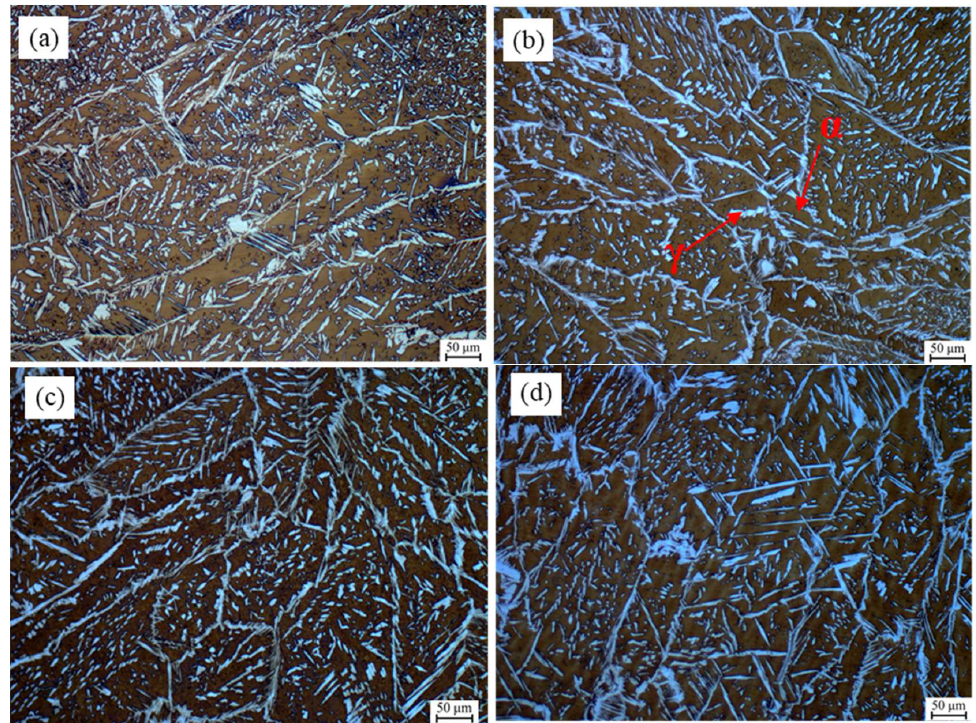
Figure 3. Microstructure of the filling weld under different alternating magnetic field parameters.